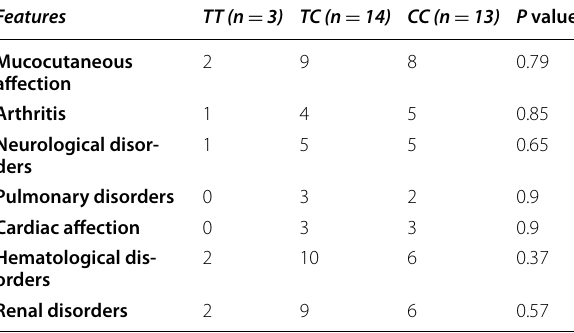
Data were analyzed using the Fisher’s exact test *Significant difference at P 0.05 ≤ Table 6 Comparisons of the frequencies of the three genotypes of rs 9340799 in SLE patients regarding different systems affected